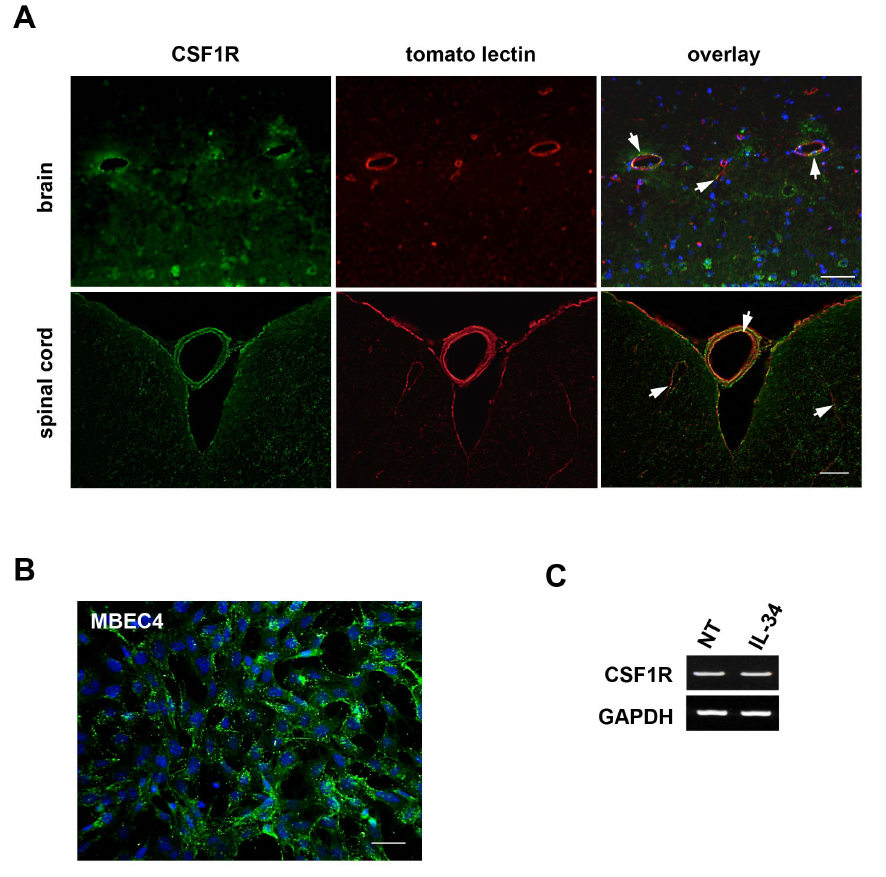
Fig. 2. CNS endothelial cells express CSF1R. (A) Immunofluorescence images of brain sections, and lumbar spinal cord sections. Green, CSF1R; red, tomato lectin; blue, Hoechst nuclear counterstain. Arrows indicate CSF1R-immunopositivity in the capillary endothelial cells. Scale bar, 50 m m. (B) Immunofluorescence image of mouse brain capillary endothelial cell line MBEC4. Green, CSF1R; blue, Hoechst nuclear counterstain. Scale bar, 50 m m. (C) RT-PCR data for CSF1R. Stimulation with IL-34 did not alter the expression of CSF1R in MBEC4